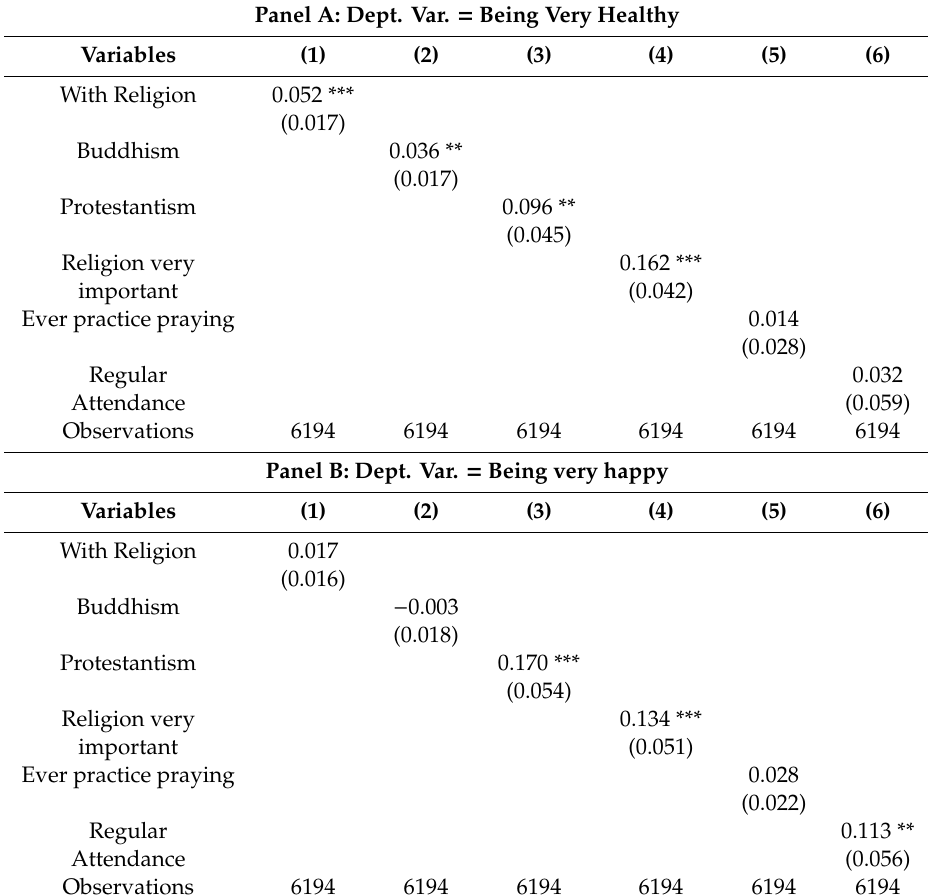
Table 4. Results estimated by propensity score matching: average treatment e ff ects (ATEs) of religion on self-reported health and